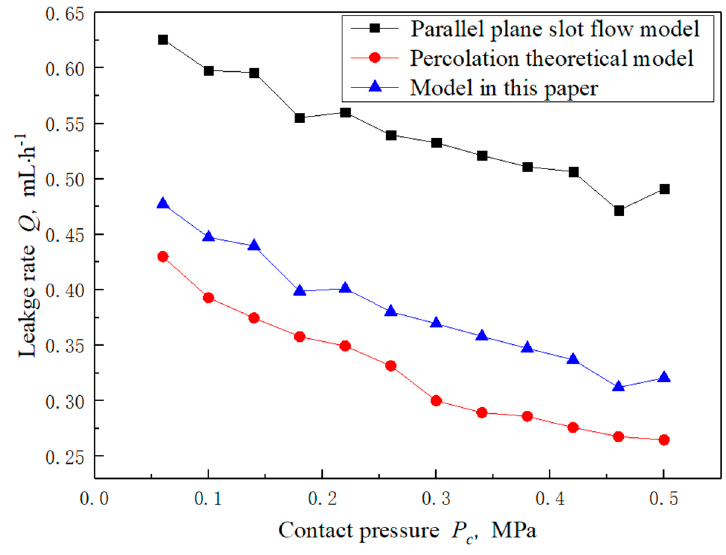
Figure 15. Comparison of leakage rates calculated using different models.